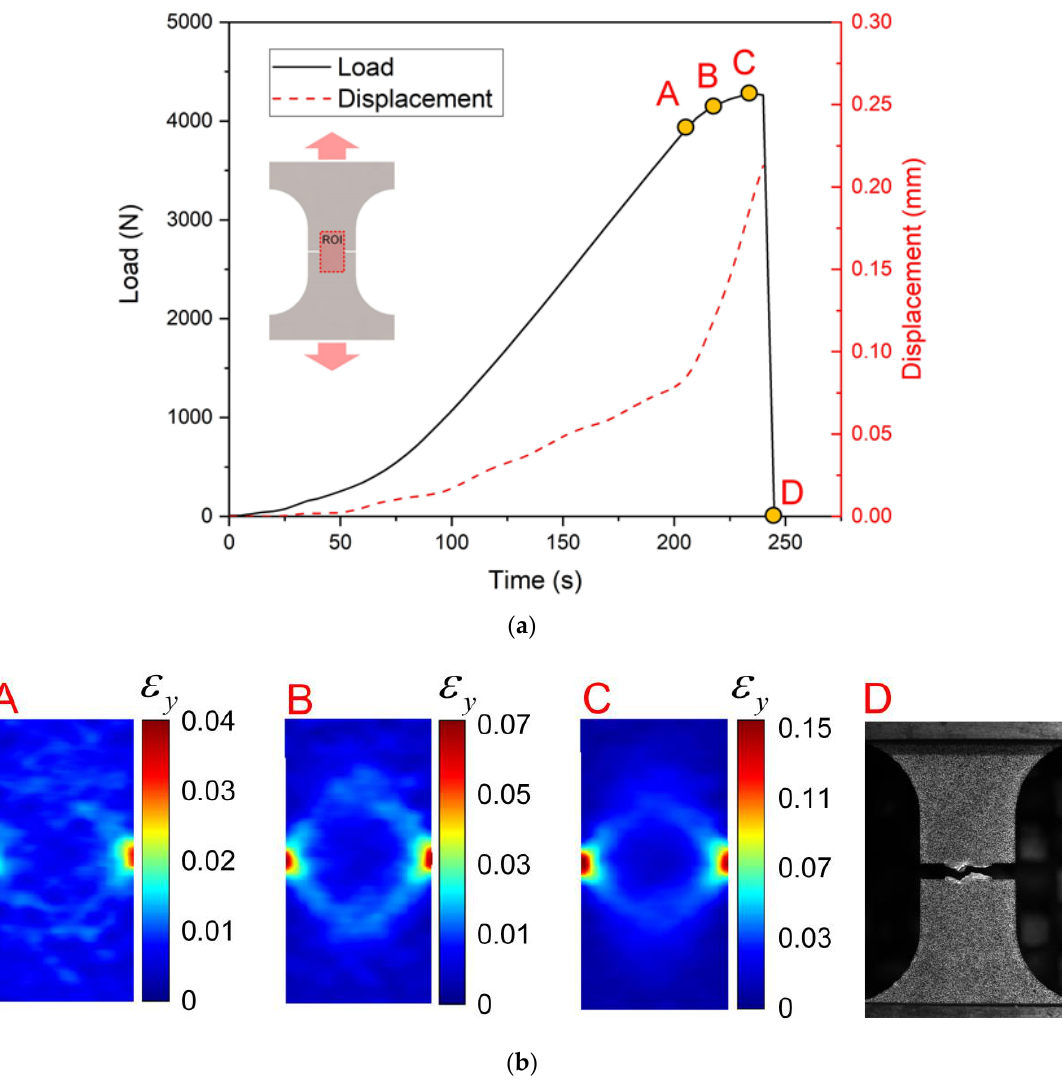
Figure 9. The loading curves and apparent strain maps for the notched tension sample (R = 0.1 mm): ( a ) Load—time and displacement—time curves; ( b ) the apparent strain ε y fields at loading points A–C and D specimen after failure.